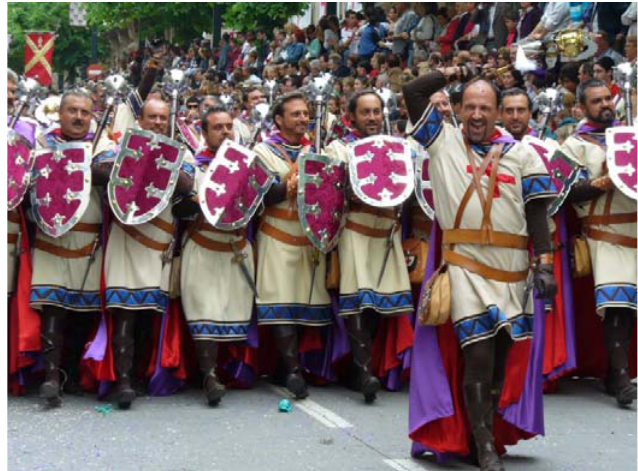
Photo by Popezz. Courtesy of Wikimedia Commons [30]. Figure 5. The domain of Moors and Christians: Alicante province, Valencia Community, Spain.